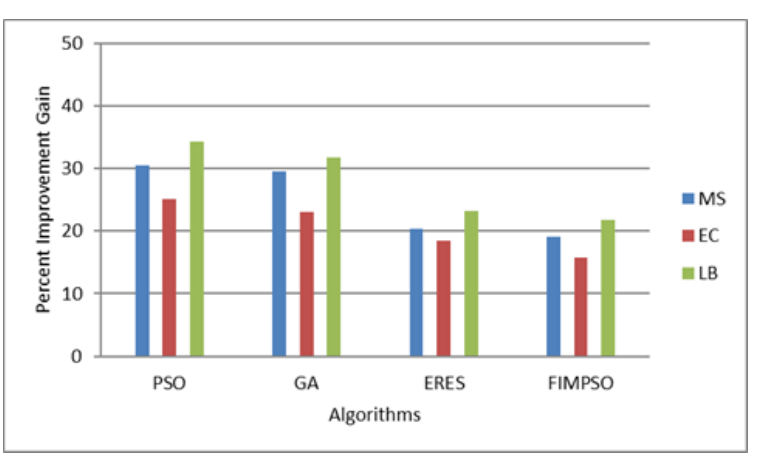
Figure 4. Percent improvement gain of the proposed algorithm over the other methods on the LIGO